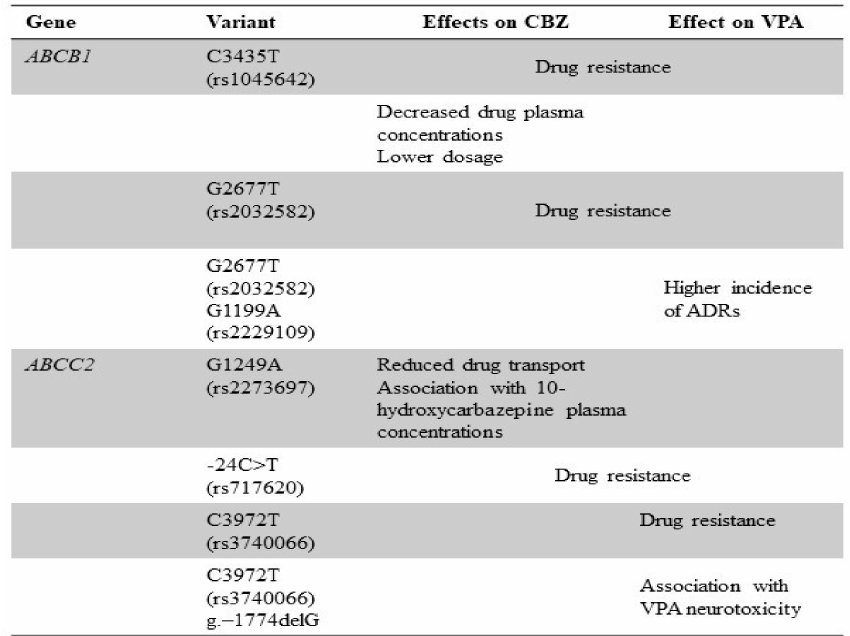
Figure 3. Genetic polymorphisms of drug transporters and carbamazepine (CBZ) and valproate (VPA) response. ABCB1 (ATP Binding Cassette Subfamily B Member 1), ABCC2 (ATP Binding Cassette Subfamily C Member 2), ADRs (Adverse Drug